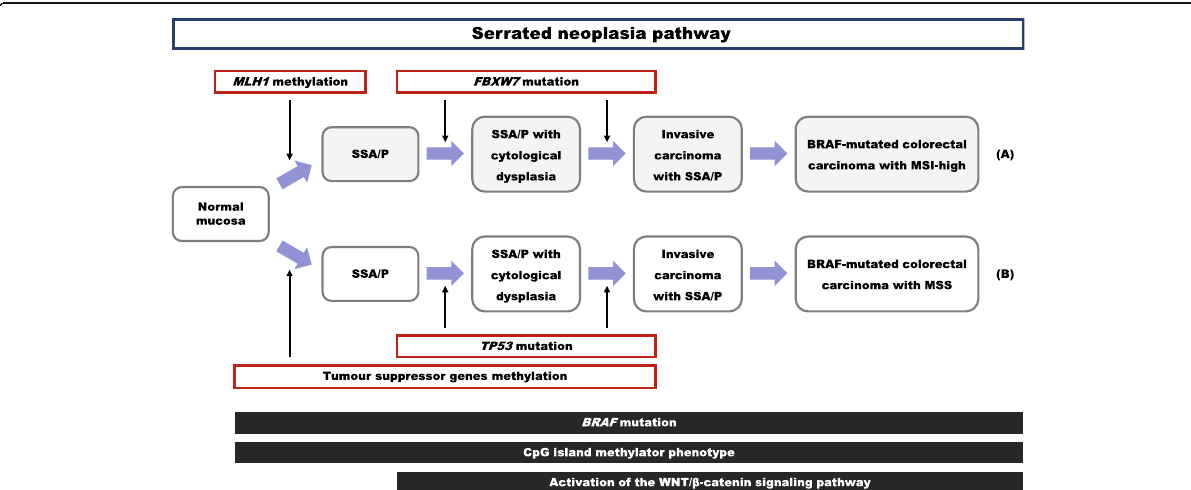
Fig. 4 Schematic representation of differences in the molecular biological expressions and genetic alterations in the serrated neoplasia pathway. Sessile serrated adenoma/polyp (SSA/P) is an early precursor lesion in the serrated neoplasia pathway that progresses to cytological dysplasia and results in BRAF -mutated colorectal carcinomas that are commonly high levels of microsatellite instability (MSI-high) (diagram A) or microsatellite- stable (MSS) (diagram B). Both pathways are associated with a CpG island methylator phenotype and WNT/ β -catenin signaling activation. a The upper arm, driven by BRAF mutation and MLH1 methylation, indicates progression to BRAF -mutated MSI-high carcinoma. FBXW7 mutations are potentially involved in progression of this pathway. b The lower arm, driven by BRAF mutation and methylation of unspecified tumor-suppressor genes, involves progression to BRAF -mutated MSS carcinoma. TP53 mutations are potentially involved in progression of this